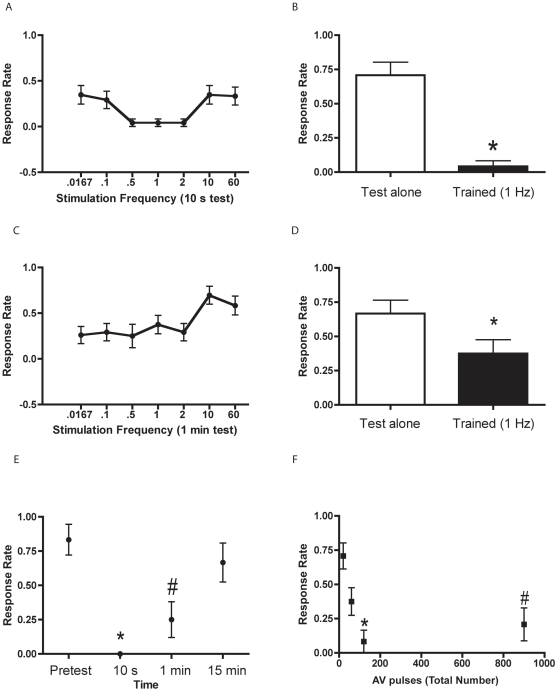
Low-frequency stimulation is more effective at eliciting rapid habituation than high-frequency stimulation.(A) Mean response rates of larval zebrafish (6–7 dpf) after 120 pulses of AV stimulation at different frequencies, tested 10 s after the last training pulse. The response rates were: 0.0167 Hz, 0.35±0.10 (n = 23); 0.1 Hz, 0.29±0.10 (n = 24); 0.5 Hz, 0.04±0.04 (n = 24); 1 Hz, 0.04±0.04 (n = 24); 2 Hz, 0.04±0.04 (n = 24); 10 Hz, 0.35±0.10 (n = 23); and 60 Hz, 0.33±0.10, (n = 24). (B) Mean rate of C-start responses 10 s after habituation training (1 Hz, 120 pulses). The Trained group (n = 24) exhibited a significantly lower response rate than did the Test alone (n = 24; t
[46] = 6.44, p<0.0001), as indicated by the asterisk. The data for the Trained group came from the experiments shown in (A). (C) Mean response rates of larval zebrafish to pulses of different auditory frequencies, tested 1 min after training. The data are from the same experiments presented in (A). The response rates were: 0.0167 Hz, 0.26±0.09 (n = 23); 0.1 Hz, 0.29±0.10 (n = 24); 0.5 Hz, 0.25±0.13 (n = 24); 1 Hz, 0.38±0.10 (n = 24); 2 Hz, 0.29±0.10 (n = 24); 10 Hz, 0.70±0.10 (n = 23); and 60 Hz, 0.58±0.10 (n = 24). (D) Mean response rate 1 min after habituation training (1 Hz, 120 pulses). The Trained group (n = 24) exhibited significantly greater habituation than did the Test alone group (n = 24; t
[46] = 2.07, p<0.05), as indicated by the asterisk. The data for the Trained group were from the experiments in (C). (E) Persistence of rapid habituation following training at 1 Hz (120 pulses). The pretest response rate was based on the response to the first stimulus of the habituation training, and posttest rates were based on the responses of the same animals (n = 12) at 10 s, 1 min, and 15 min after training. To determine when the response rate returned to baseline levels, we performed a repeated measures ANOVA (F
[3,33] = 12.72, p<0.0001). SNK post hoc tests used to probe for significant differences among the responses to the various tests indicated that habituation was present at 10 s and 1 min after training compared to the pretest and 15 min posttest (p<0.05 for each comparison), whereas no habituation was present at the 15 min posttest compared to the pretest response rate (p>0.05). The asterisk indicates a significant difference between the 10 s test and the pretest and 15 min test values, whereas a pound sign indicates a significant difference between the 1 min test and the pretest and 15 min test values. (F) Number of pulses required to elicit rapid habituation (1-Hz stimulation). To determine the most effective number of pulses to elicit habituation (1-min posttest), we first performed a one-way ANOVA, which showed that the groups differences were significant (F
[3, 92] = 9.89, p<0.0001). SNK post hoc tests indicated that the group that received 120 AV pulses had a significantly lower response rate than the groups that received only 20 or 60 AV pulses (p<0.05 for each comparison), as indicated by an asterisk. The group that received 900 pulses was significantly less responsive than the group that received 20 pulses (p<0.05), as indicated by a pound sign.